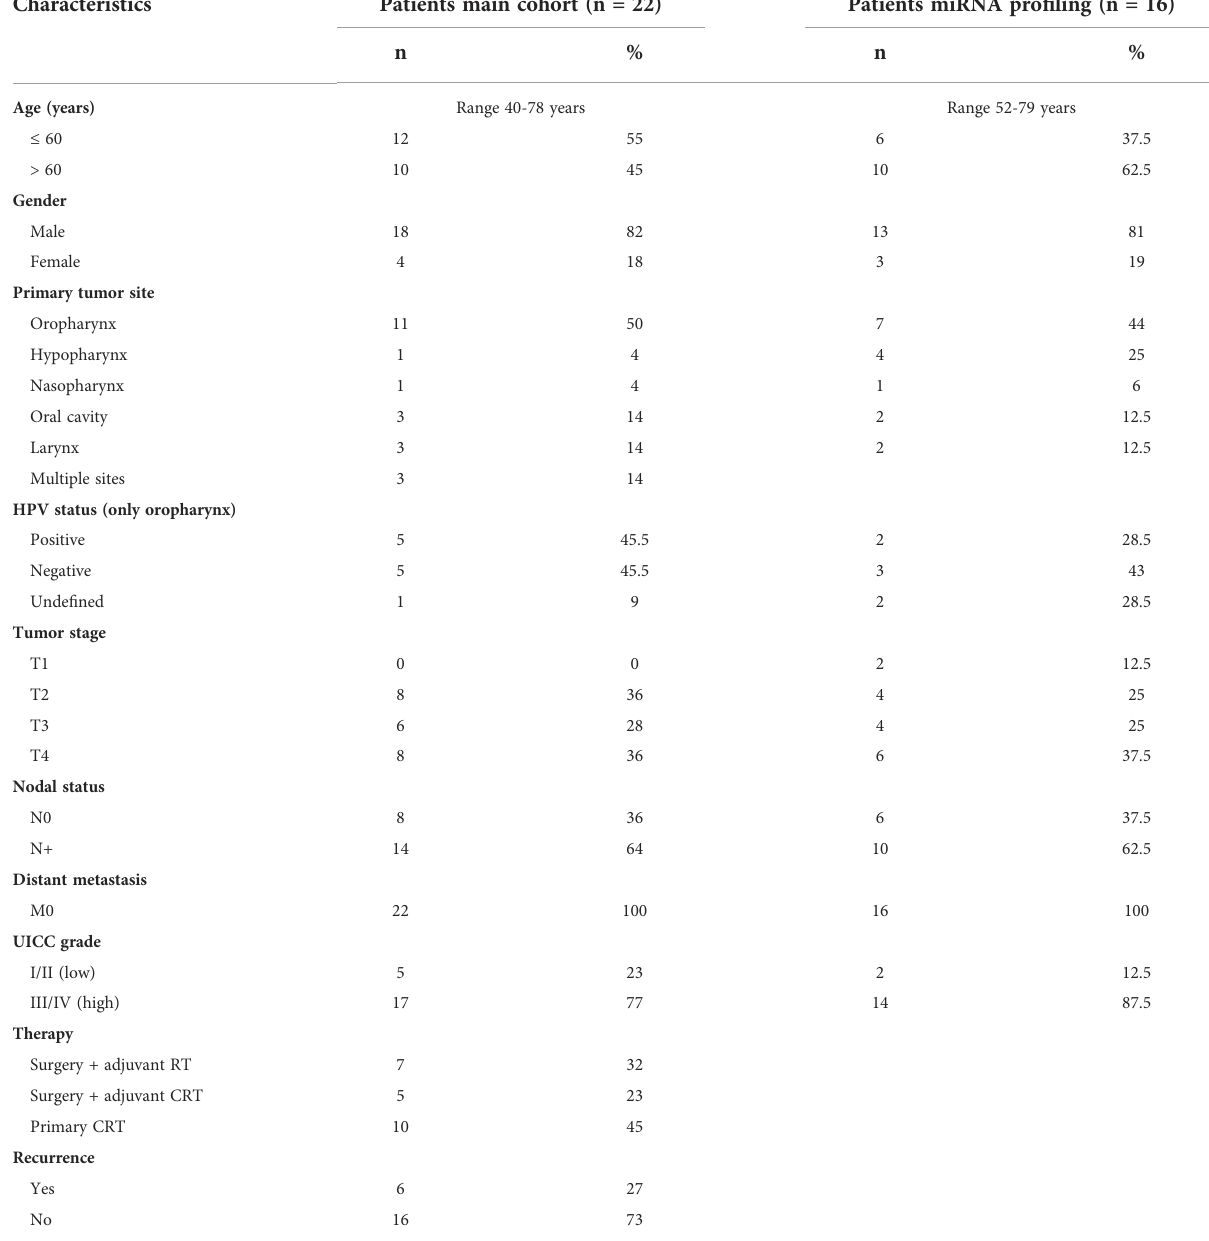
TABLE 1 Clinicopathological data of HNSCC patients enrolled in this study.